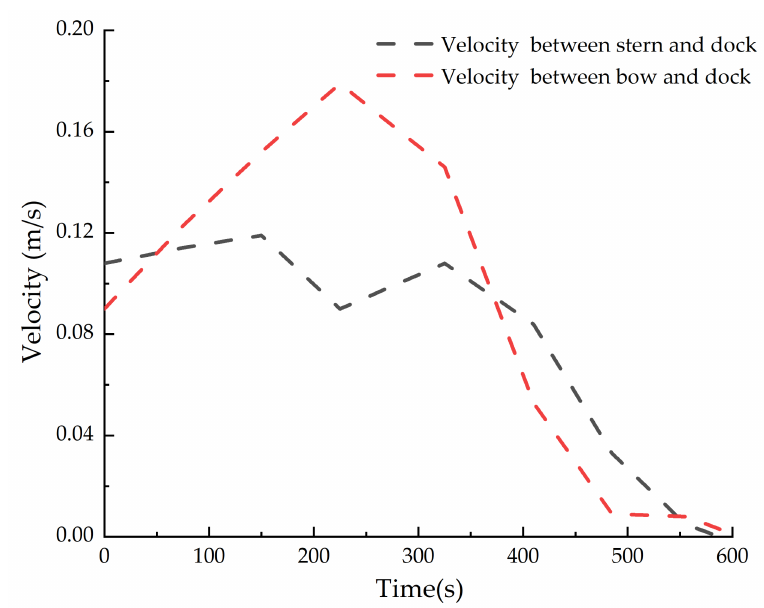
Figure 18. Velocity of the stern and bow relative to the